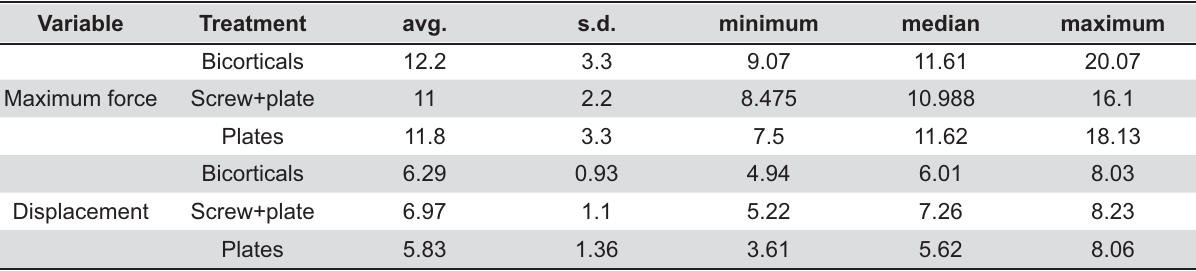
Where: x- mean; s.d.- standard